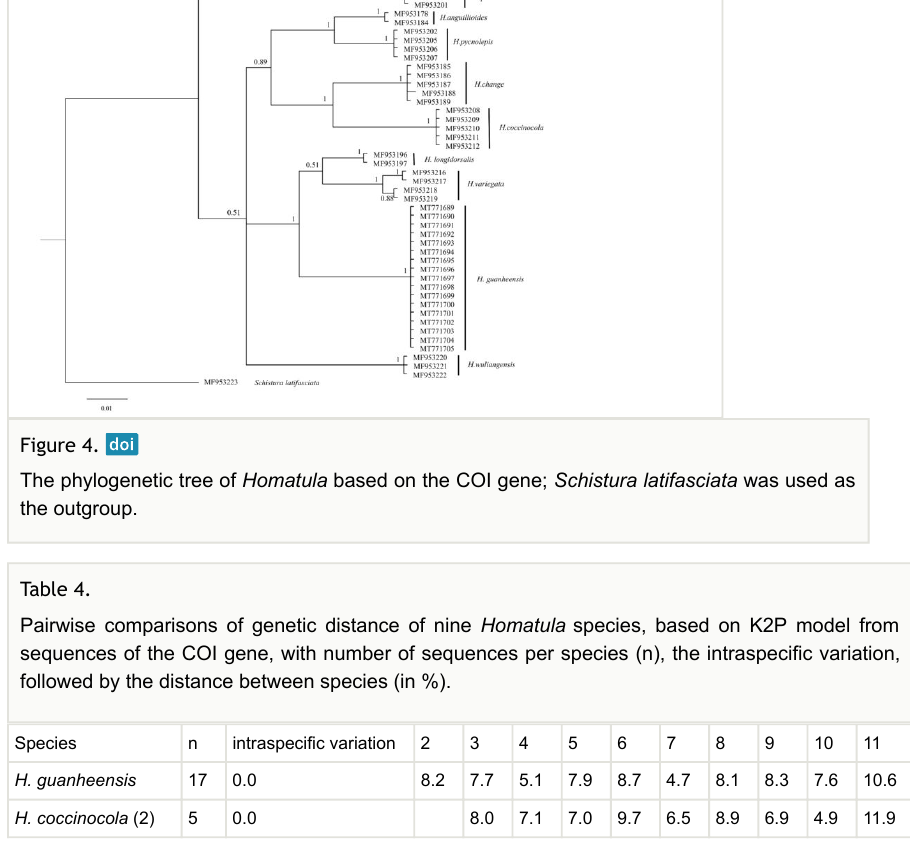
Table 5. Genetic distance between H. guanheensis and other given species displayed 4.7%–10.6% variation in the COI base pairs (Table 4). The smallest distance, 2.9% (5 vs. 9) was detected between H. pycnolepis and H. anguillioides . Based on the Cyt b gene, the phylogenetic tree analysis showed that H. guanheensis is a monophyletic group with a high posterior probability value (100%; Fig. 5). Through the results of the genetic distance analysis, we found that H. guanheensis differed from the acquired congeners by 4.2%– 10.3%. The genetic distance between H. guanheensis and similar species exceeded 2% variation, while the intraspecific variation of H. guanheensis was 0% (Table 5).